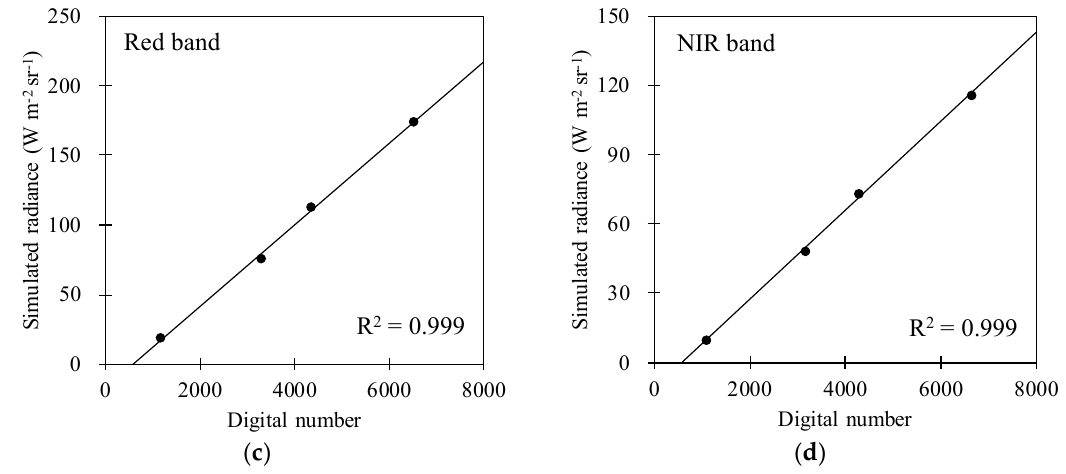
Figure 10. Scatterplots between KOMPSAT-3 DN and simulated TOA radiance fine all multispectral bands acquired on 20 September 2017; ( a – d ) represent the blue, green, red, and NIR bands, respectively.